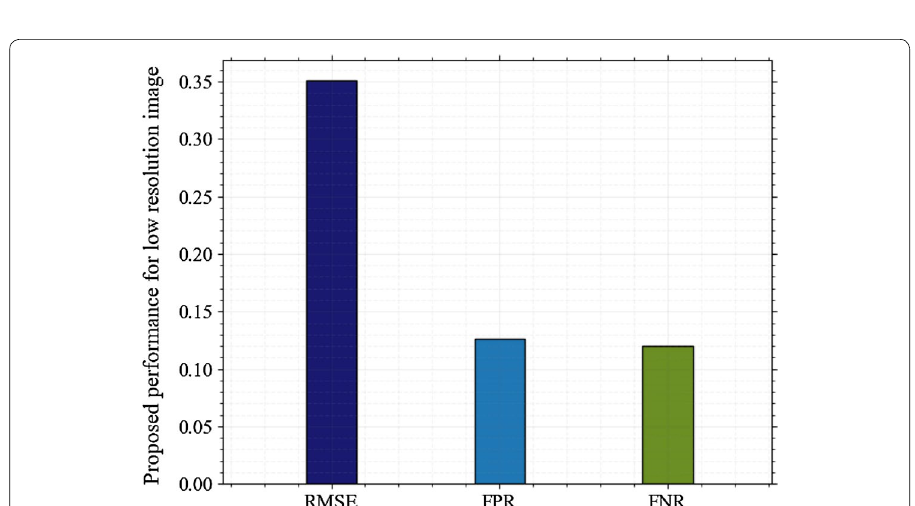
Fig. 15 Low resolution for RMSE, FPR and